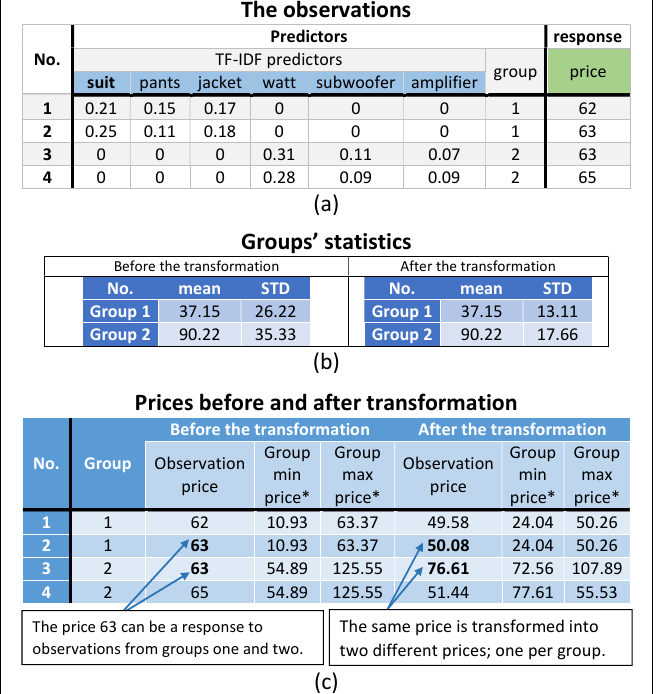
Figure 1. A motivational example of within-group variation reduction. * For 68% of the data ( µ ± σ